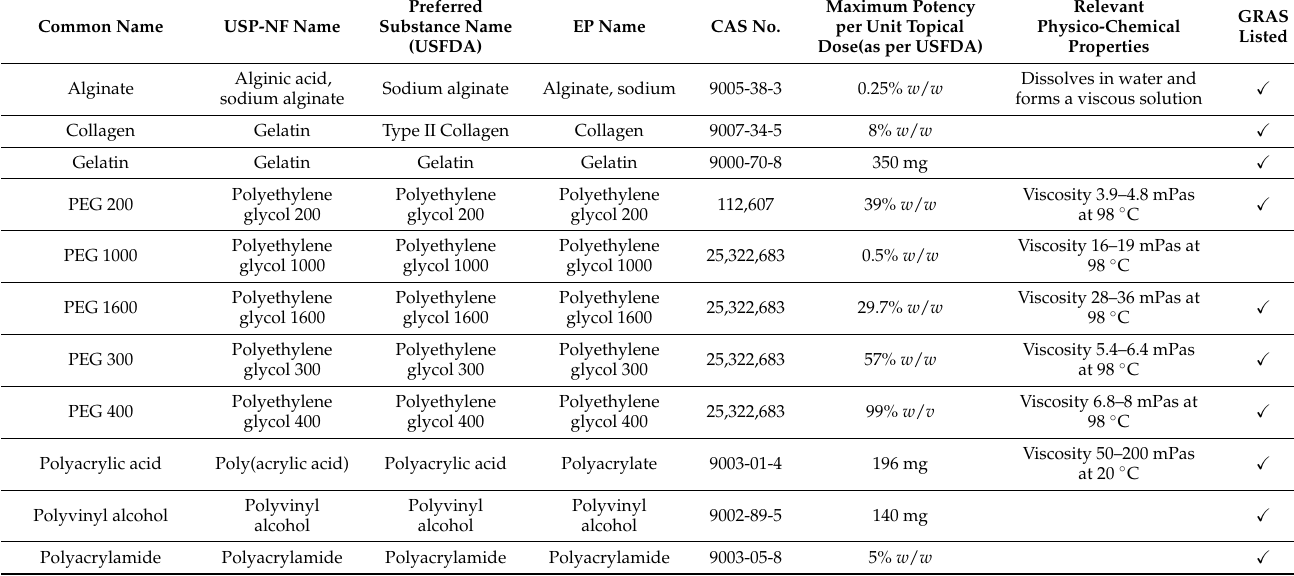
Table 6. Regulatory information about some hydrogel ingredients